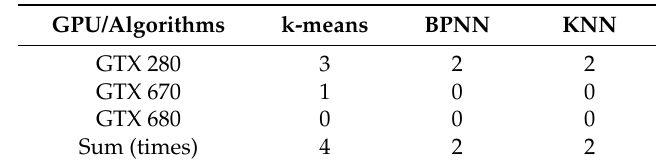
Table 6. Fault node information of optimized algorithms.